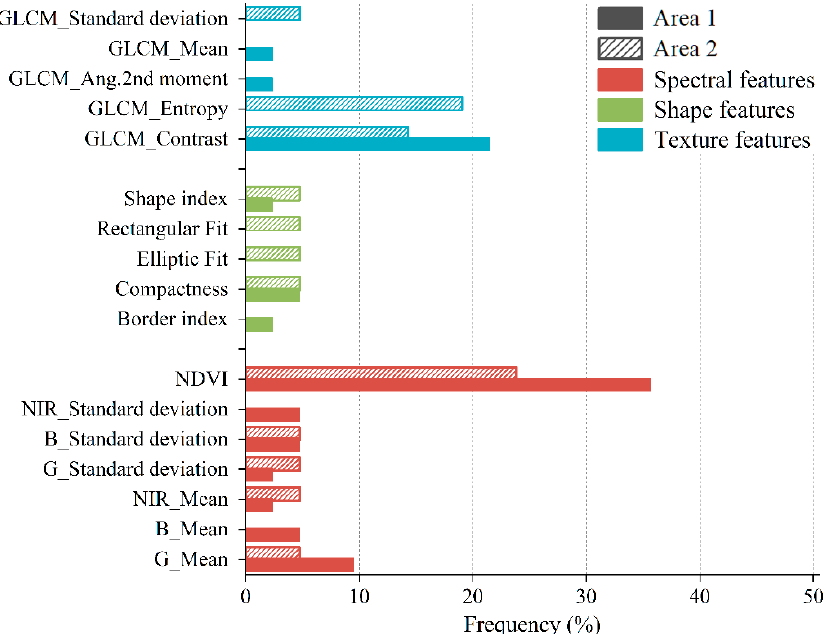
Figure 10. The frequency of the original features in the GP individuals/classifiers. Features with a frequency of 0 in both areas are not listed.